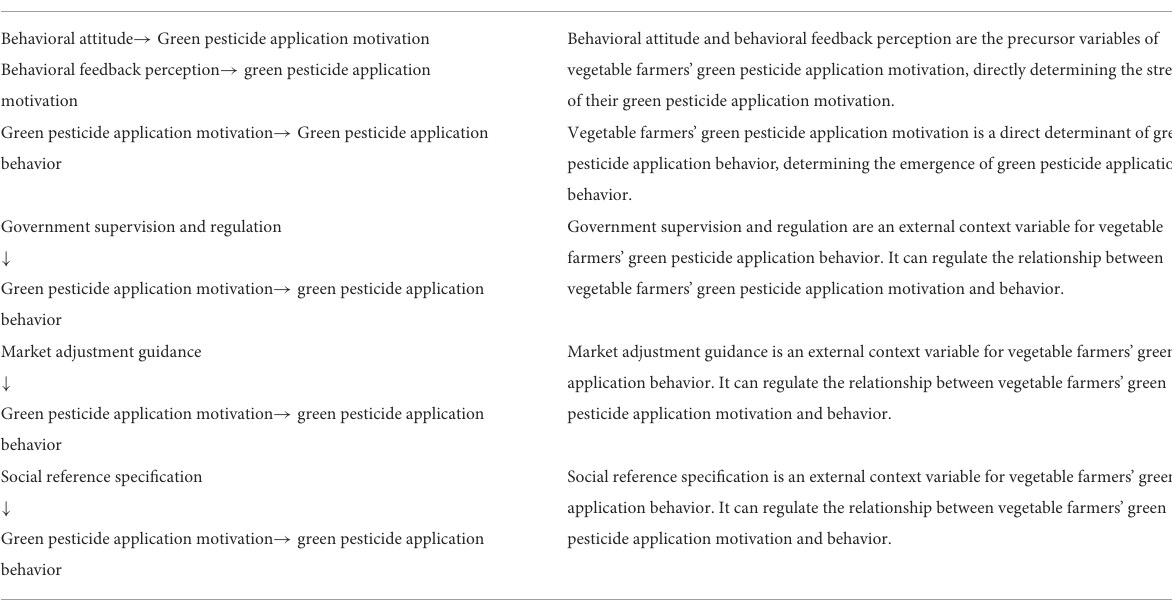
TABLE 4 Storylines (typical logical